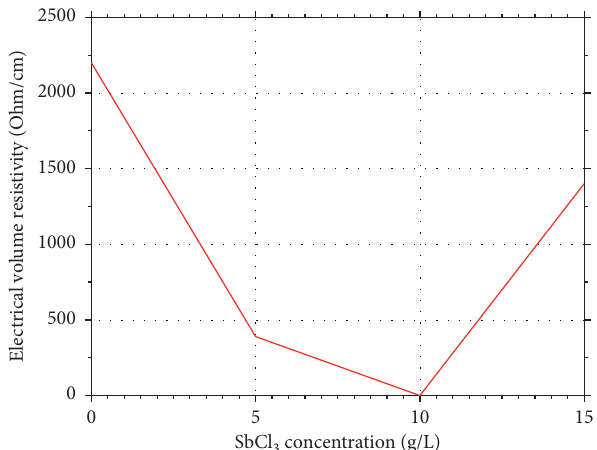
Figure 5: Electrical volume resistivity vs. Sb concentration in the reactant mixture of particles after annealing at 450 ° C for 5h.